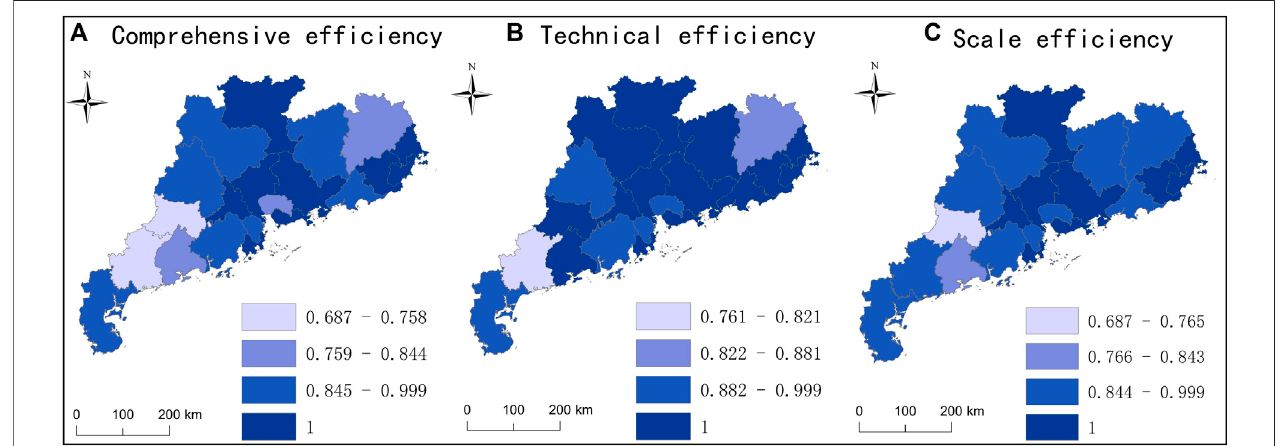
FIGURE 6 | Ef fi ciency distribution map in prefecture-level cities in 2019 –